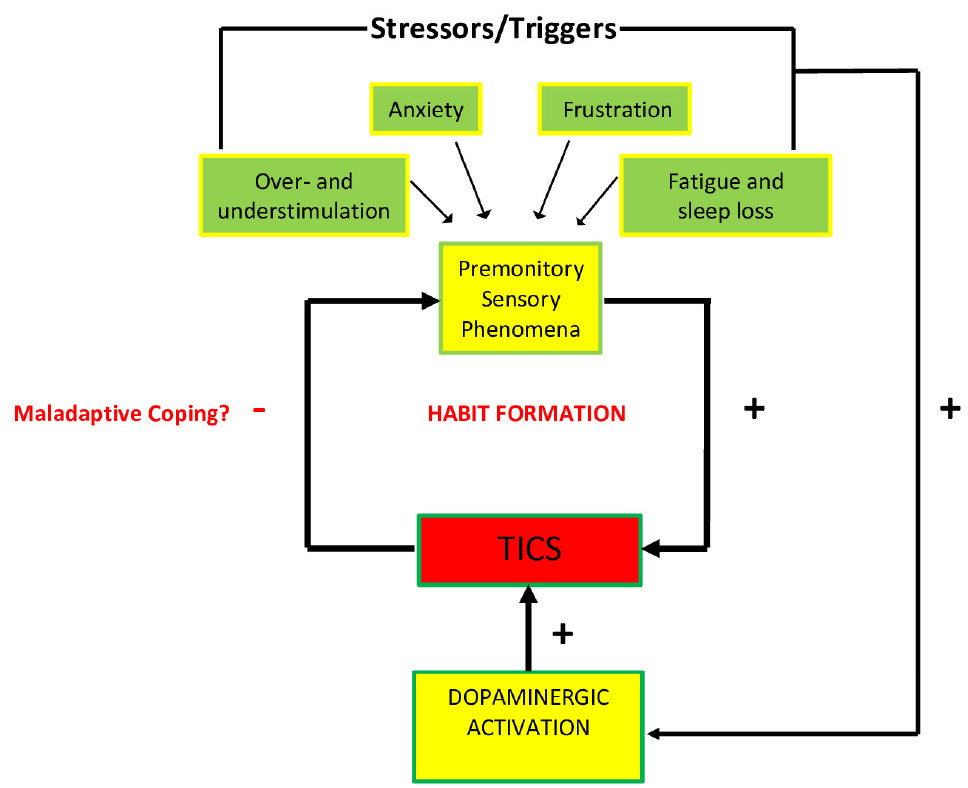
Figure 3. Diagrammatic representation of the association between promontory sensations and ticking behavior. Environmental and contextual triggers intensify PSPs, as well as dopaminergic activity that are hypothesized to increase tic behavior. The tics themselves affect the intensity of PSPs that could in turn potentially create a maladaptive habit as a coping mechanism (after Godar, S. C., and Bortolato, M. (2017). What makes you tic? Translational approaches to study the role of stress and contextual triggers in Tourette syndrome. Neuroscience & Biobehavioral Reviews, 76 , 123–133. doi:10.1016/j.neubiorev.2016.10 (2017), with